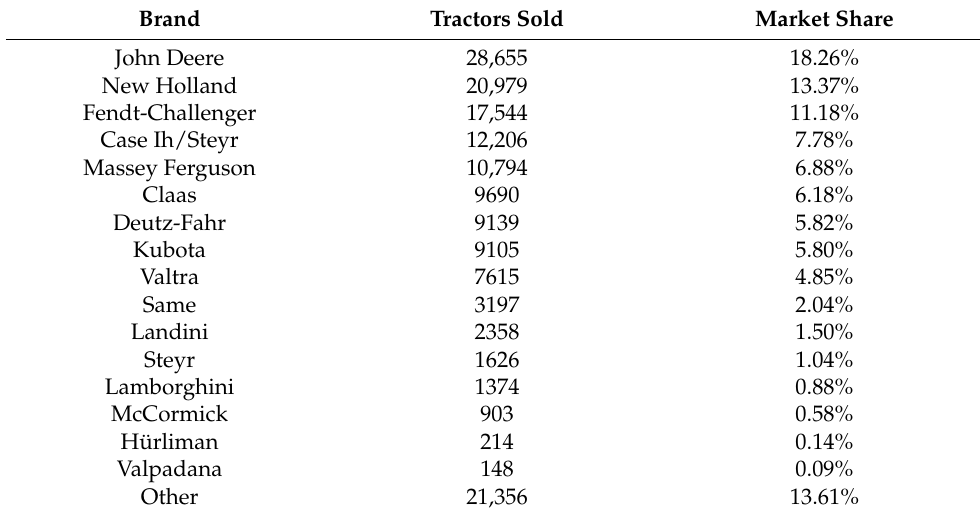
Table 2. Top brands of new tractor sales in Europe in the year 2020 [3]. Brand Tractors